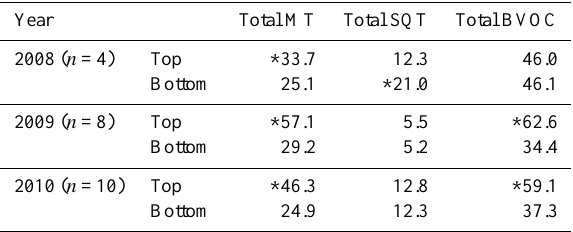
Table 2. Average concentration (µmoldwg − 1 ) of terpenes at the top (6–17m) and bottom (2–4m) of overstory trees.